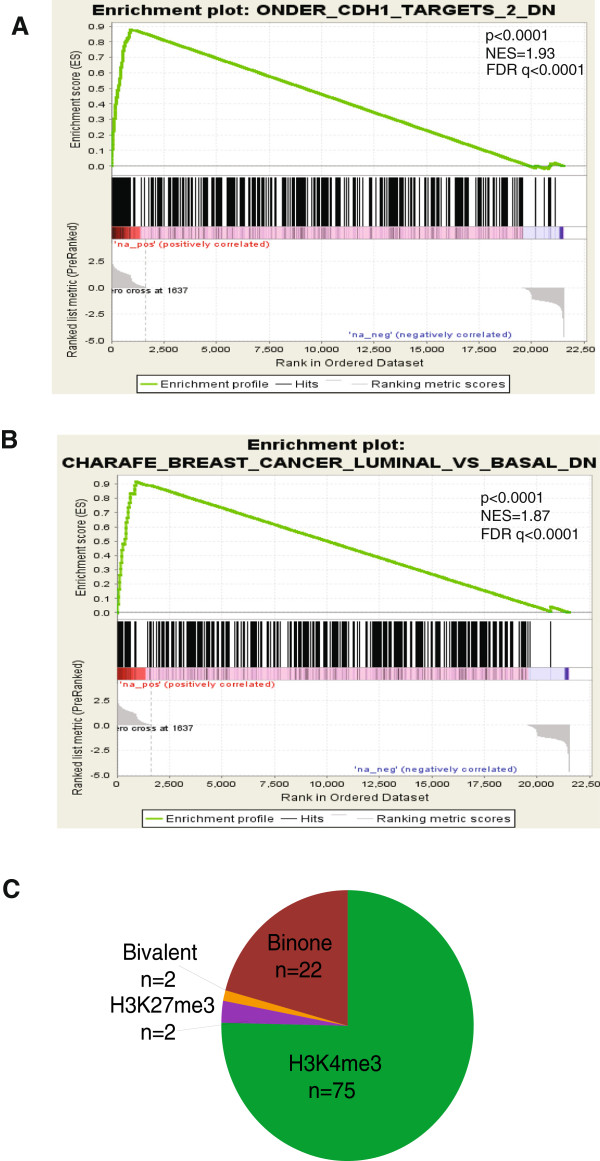
Gene set enrichment analysis of H3K27me3 marks. (A) Gene set enrichment analysis showing positive enrichment for H3K27me3 marks in genes which are down-regulated by the CDH1-knockdown model of EMT (P <0.0001). The bottom graph represents the rank-ordered, non-redundant list of genes. Genes on the far left (red) correlated the most with decreased gene expression following CDH1-knockdown. The vertical black lines show the position of each of the genes of the studied gene set in the ordered, non-redundant data set. The green curve is related to the enrichment score curve. (B) Gene set enrichment analysis showing positive enrichment for H3K27me3 marks in genes distinguishing luminal from basal like breast cancer (P <0.0001). (C) Pie chart showing that the majority of downregulated genes in the CDH1-knockdown model of EMT which gain H3K27me3 in Twist1-cells were also pre-marked by H3K4me3 in vector cells. FDR, false discovery rate; NES, normalized enrichment score.